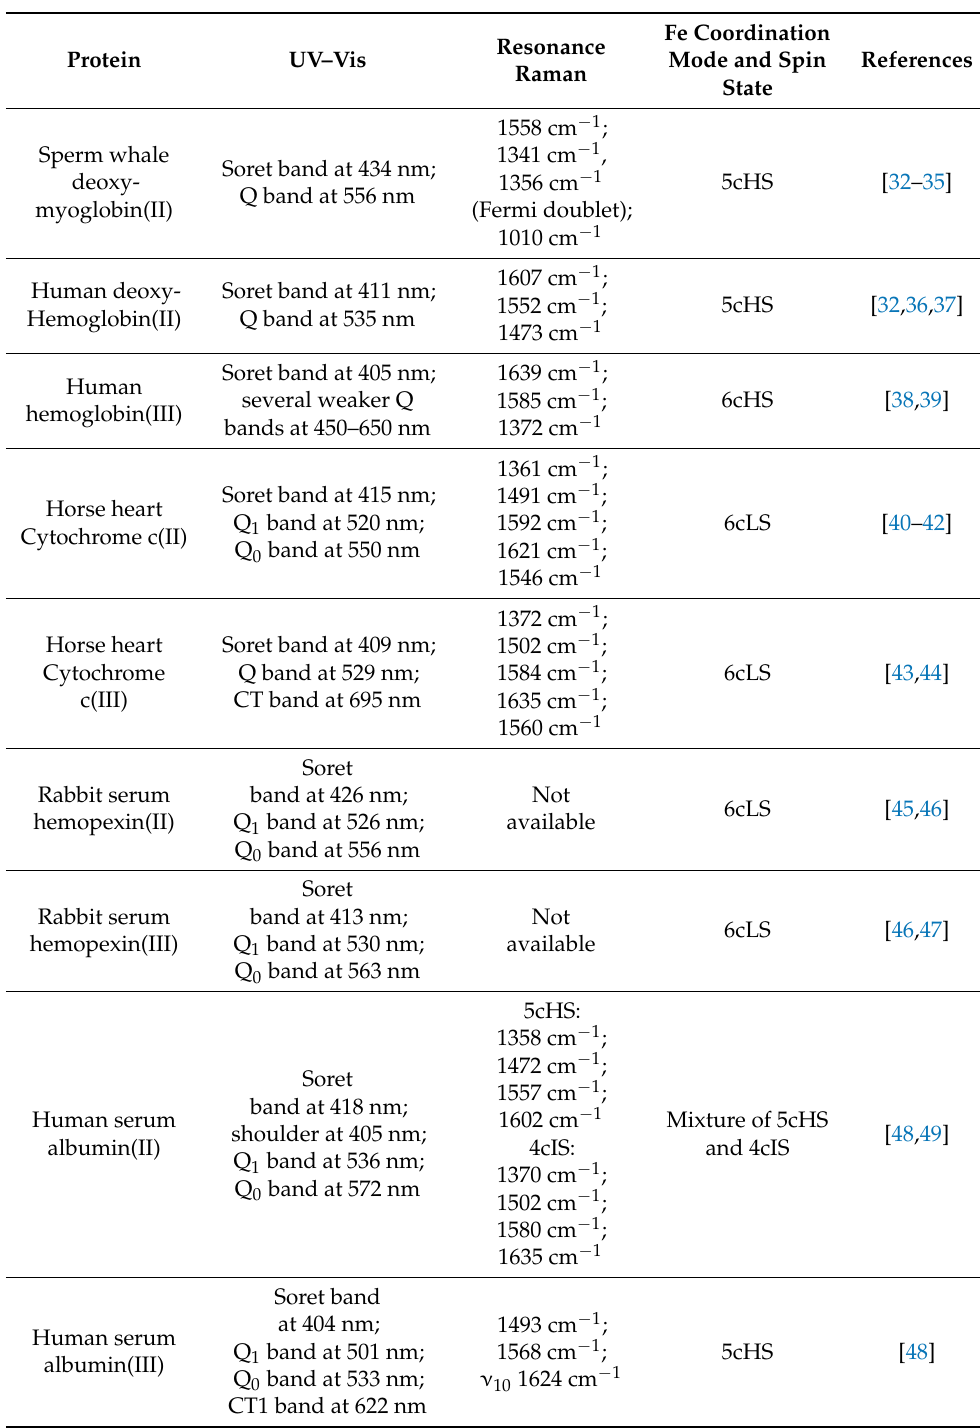
Table 1. Main spectroscopic properties of representatives of the hemoprotein classes described in this